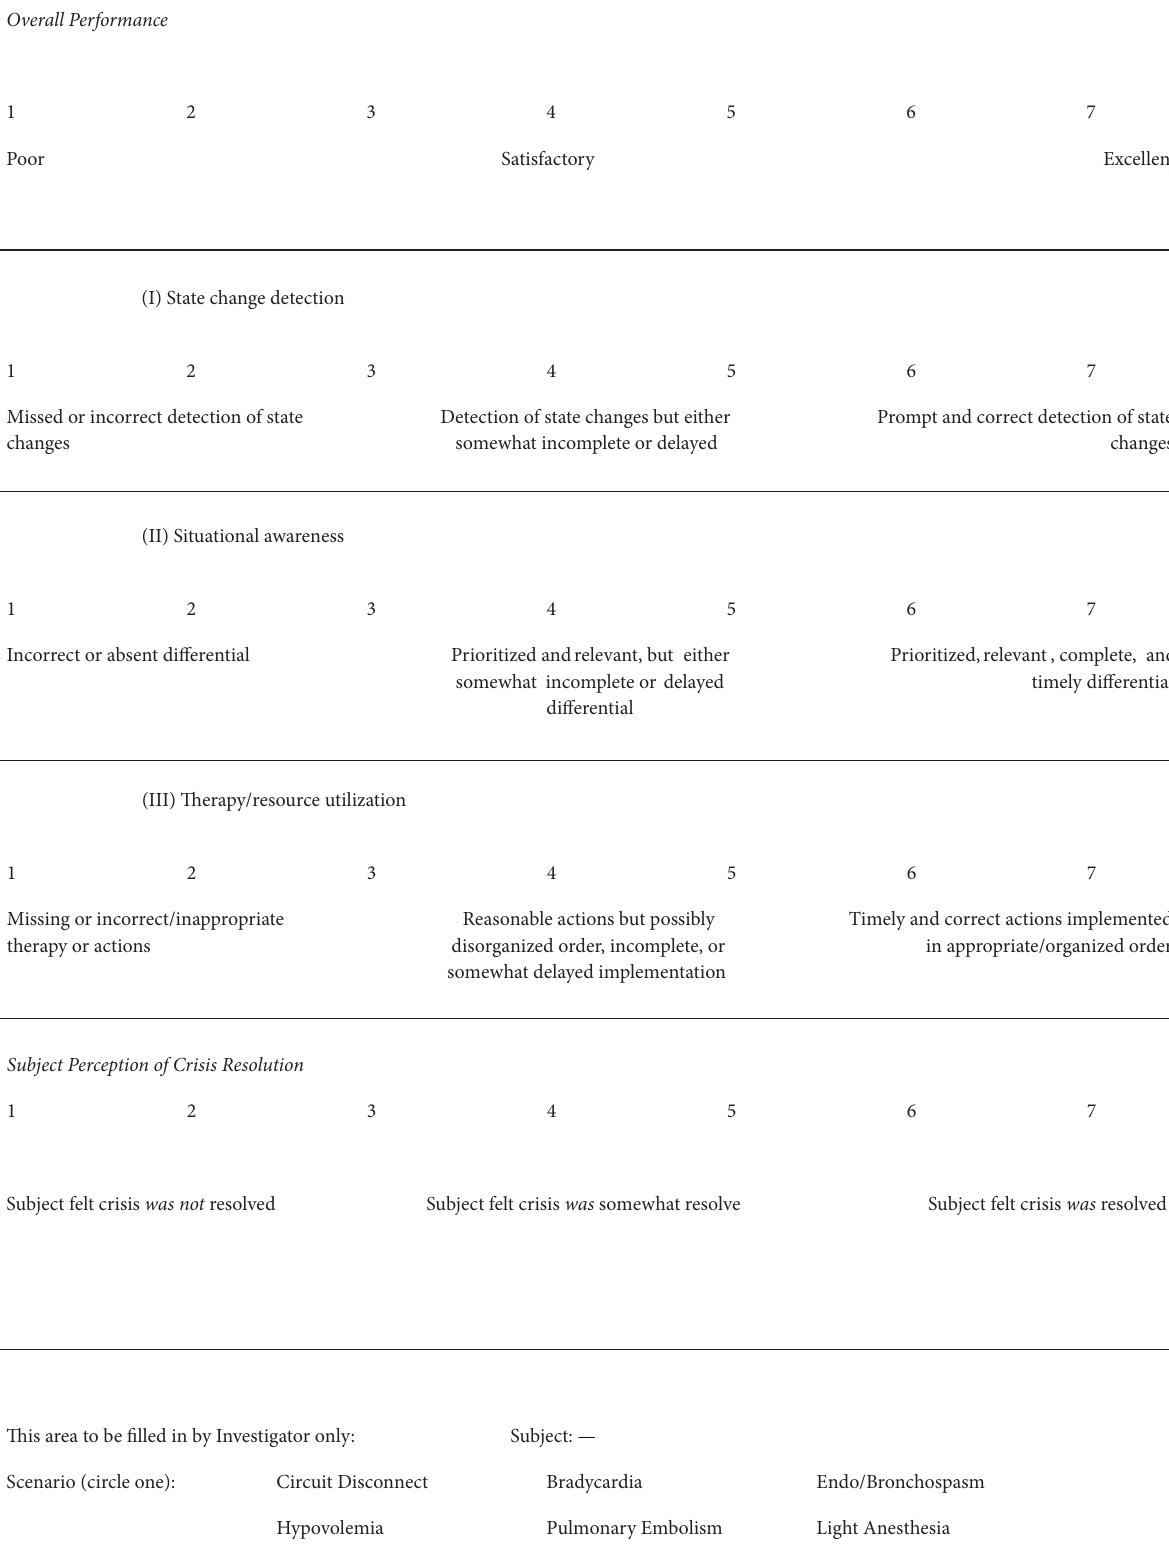
Figure 7: Global Rating Scale used by expert raters to assess performance of subjects in